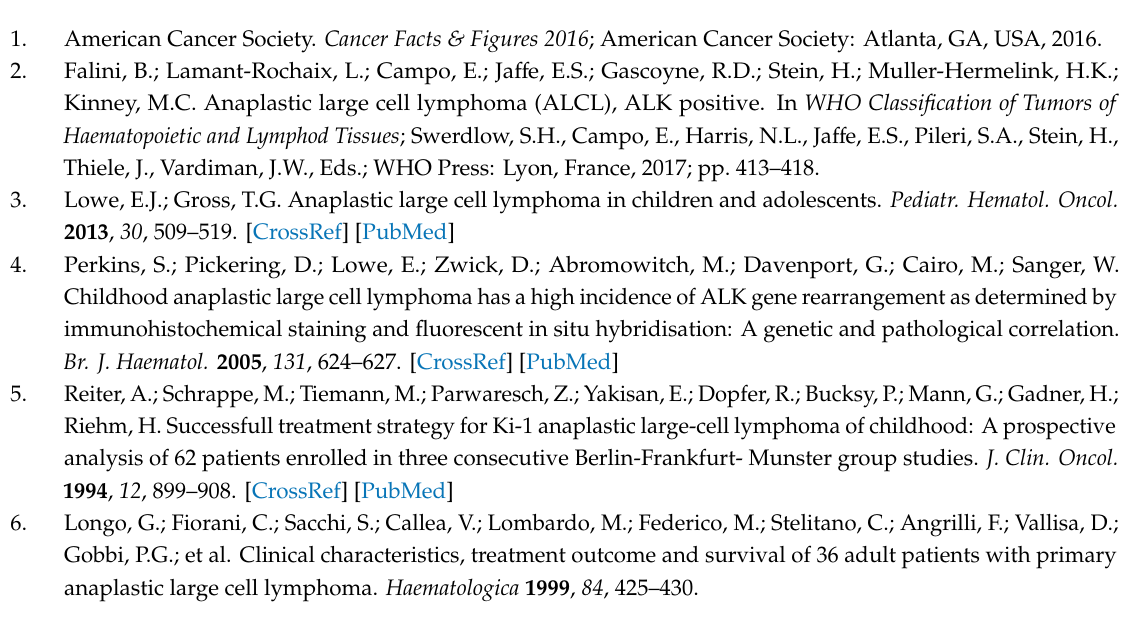
Figure S1: Therapeutic e ff ects of target chemotherapy alone vs. combined chemotherapy and gene